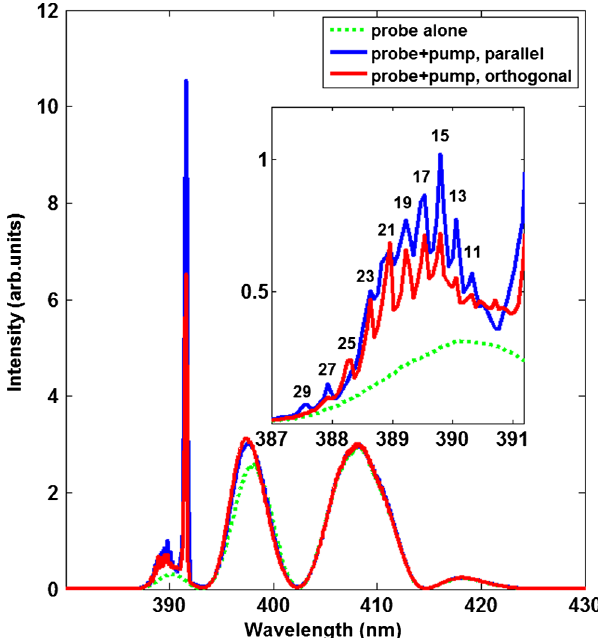
FIG. 1. The forward-probe-pulse spectra captured with the polarization direction of the probe pulse parallel (blue line) or perpendicular (red line) to the pump pulse. The inset shows the enlarged spectral region in the spectral range of 387–391 nm corresponding to the R -branch transition, and the numbers label the upper rotational levels. The estimated intensities of the pump and the probe pulses are on the orders of 10 15 W = cm 2 and 10 12 W = cm 2 , respectively, by assuming a linear propagation